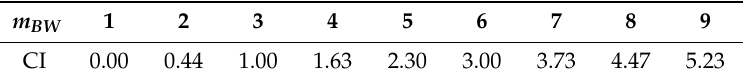
Table 3. The value of the consistency index